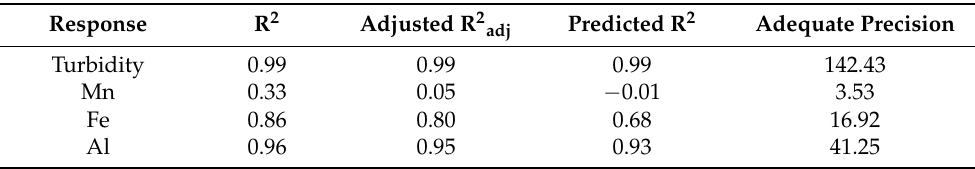
Table 5. ANOVA analysis for quadratic model for each response.